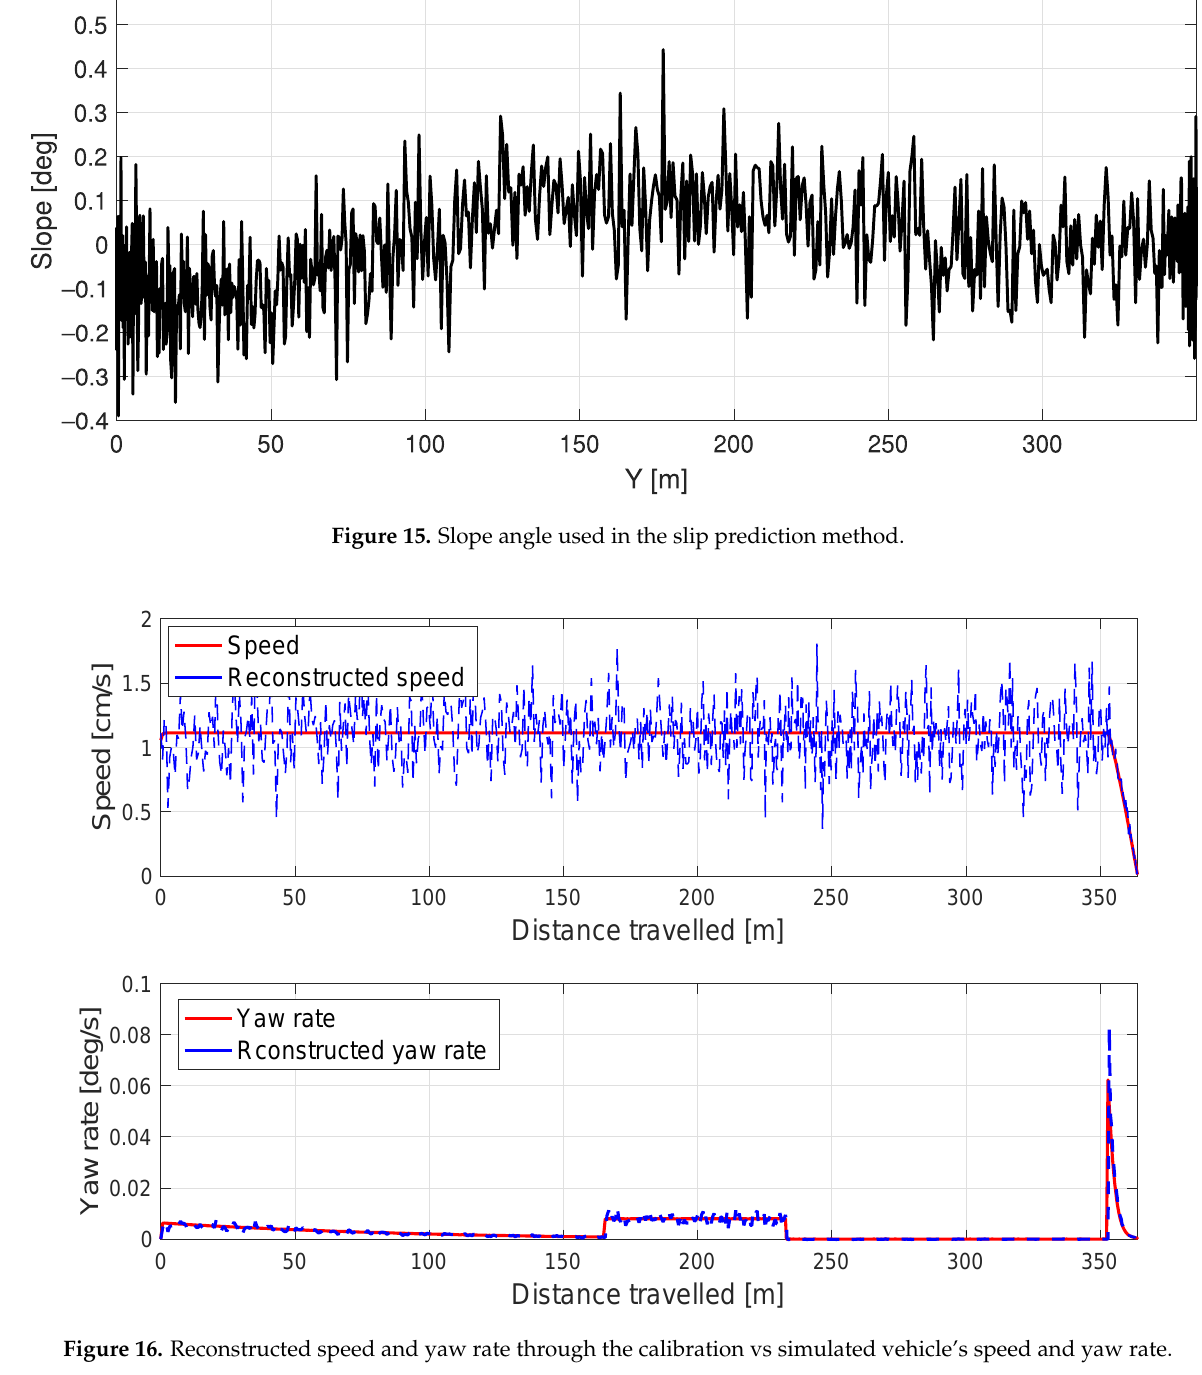
Figure 16. Reconstructed speed and yaw rate through the calibration vs simulated vehicle’s speed and yaw rate.